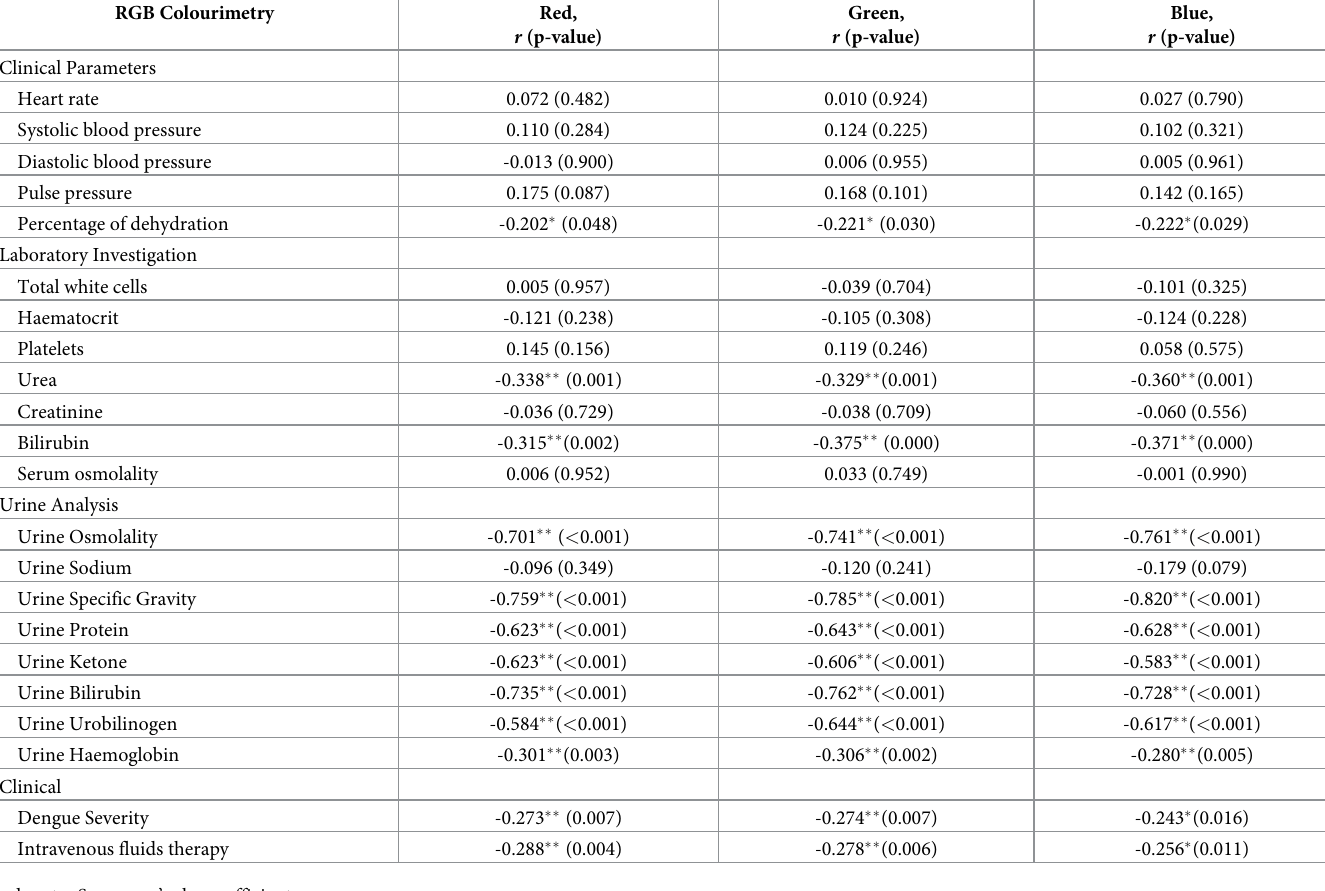
Table 3. Spearman Correlation Analysis between clinical and laboratory parameters with RGB urine